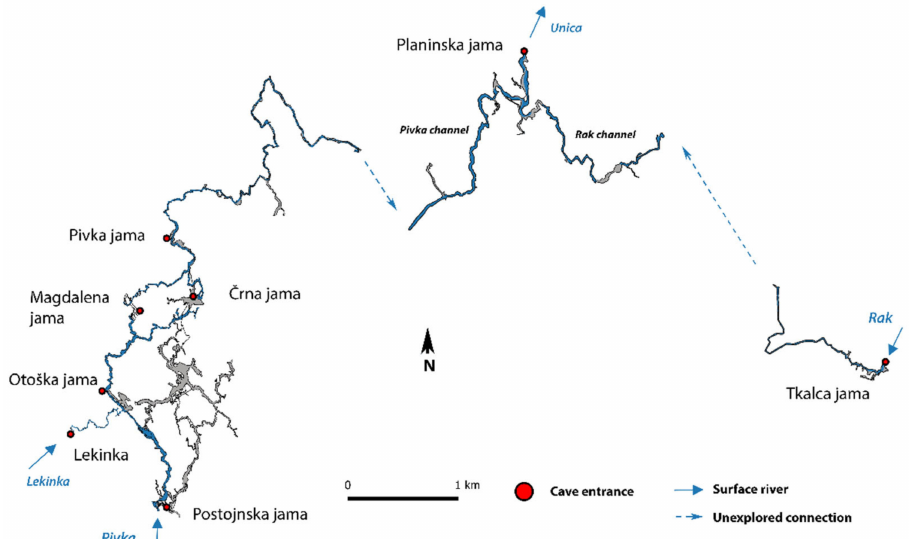
Figure 4. The plan of the Postojna-Planina Cave System, with labelled entrances to individual caves. Subterranean connections, which have not yet been explored by man, are marked with dashed blue arrow lines, while full blue arrow lines and blue names indicate surface rivers entering/leaving the system. We modified the base line outline of the caves, originally provided by the Karst Research Institute in Postojna,